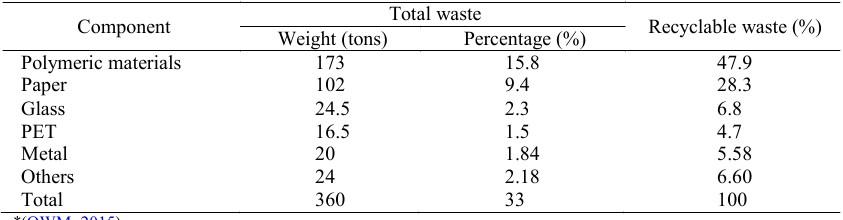
Table 3: The composition of recyclable waste*